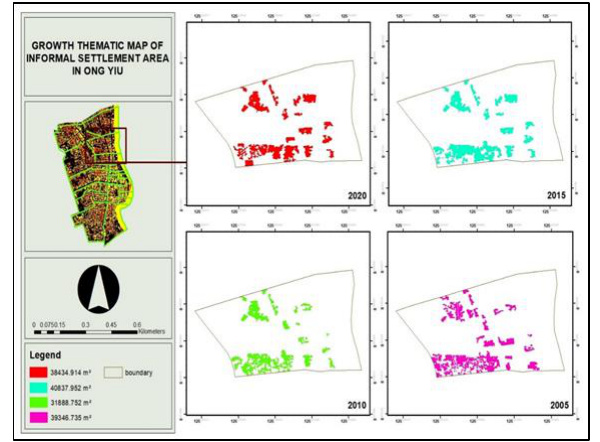
Figure 17. Thematic Map of Brgy. Ong Yiu from 2005-